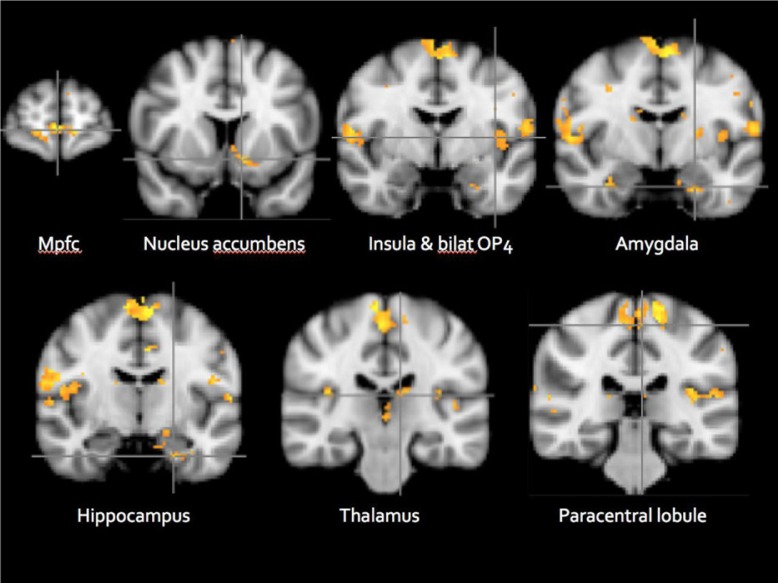
Imagined stimulation by dildo>speculum (ID>IS) (cluster z=1.65, p<0.01, N=11).Mpfc, medial prefrontal cortex; Bilat Op4, bilateral parietal operculum 4; MNI_152 coordinate: y=62/10/−4/−6/−30/−24/−10.